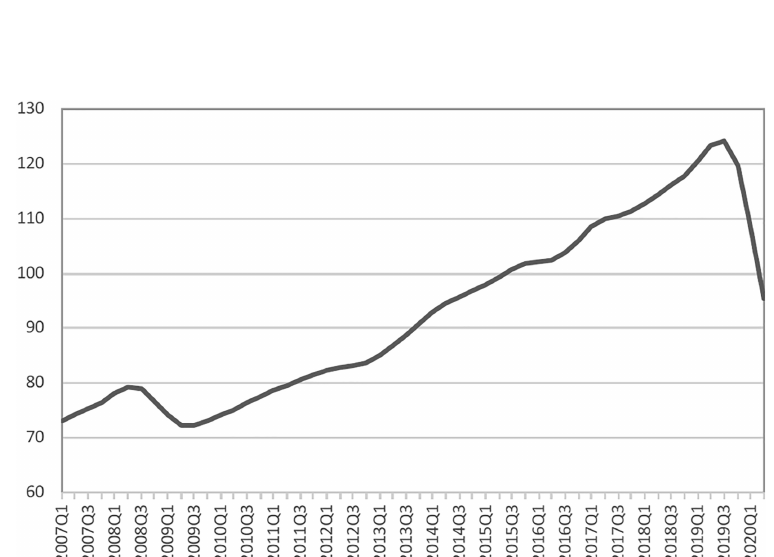
Figure A2. Merchandise exports and imports by region